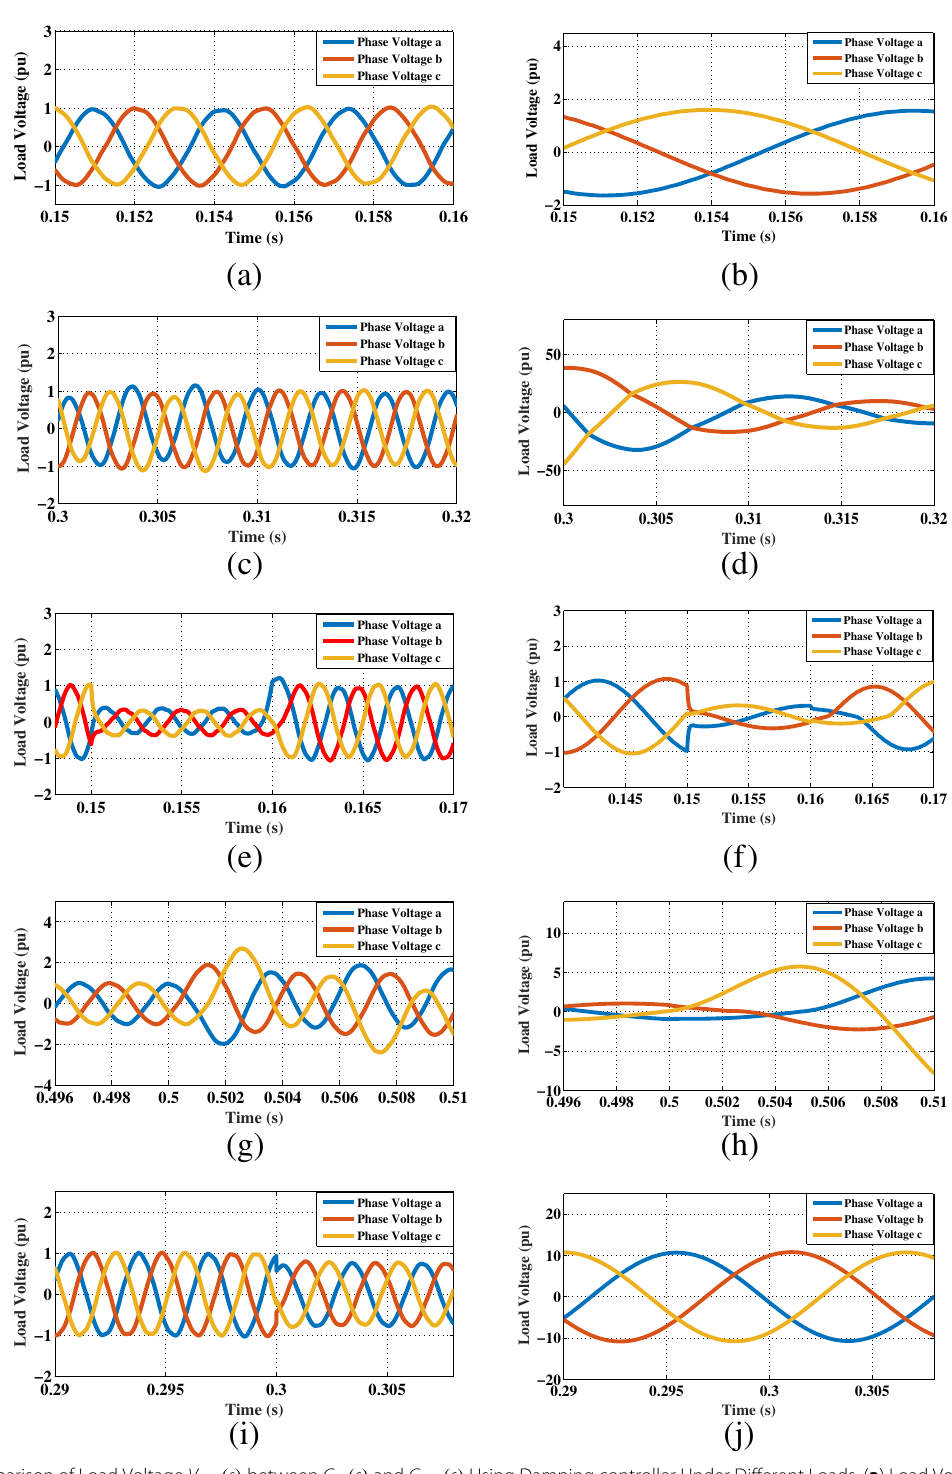
Fig. 21 Comparison of Load Voltage V abc ( s ) between G M ( s ) and G Mcl ( s ) Using Damping controller Under Different Loads, ( a ) Load Voltage of G Mcl ( s ) When Using Consumer Load, ( b ) Load Voltage of G M ( s ) When Using Consumer Load, ( c ) Load Voltage of G Mcl ( s ) When Using Non-linear Load, ( d ) Load Voltage of G M ( s ) When Using Non-linear Load, ( e ) Load Voltage of G Mcl ( s ) When Using Balanced Load, ( f ) Load Voltage of G M ( s ) When Using Balanced Load, ( g ) Load Voltage of G Mcl ( s ) When Using Unbalanced Load ( h ) Load Voltage of G M ( s ) When Using Unbalanced Load, ( i ) Load Voltage of G Mcl ( s ) When Using Unknown Load and ( j ) Load Voltage of G M ( s ) When Using Unknown